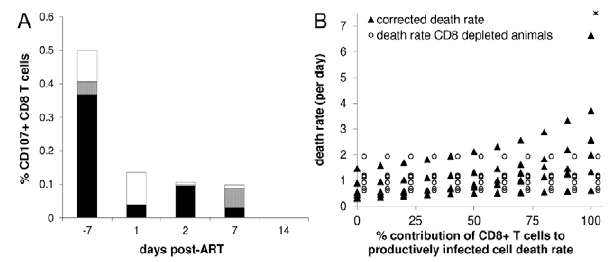
Figure 1. Effect of ART-treatment on CD8 + T cell function. A) Frequency of CD107 + CD8 T cells. Cells were stimulated ex vivo with either gag (black), pol (grey) or env (white) peptides and CD107- expression was measured. B) Death rate of short-lived productively infected cells corrected for reduced CTL function after ART treatment at different contribution of CD8 + T cells to total death rate (filled triangles; mean from left to right: 0.67, 0.72, 0.77, 0.83, 0.94, 1.04, 1.16, 1.32, 1.51, 1.67, 2.77d 2 1 ) compared to the death rate of short-lived productively infected cells in CD8-depleted animals (open dots; offset to the right, these estimates are independent of f, mean 1.08d 2 1